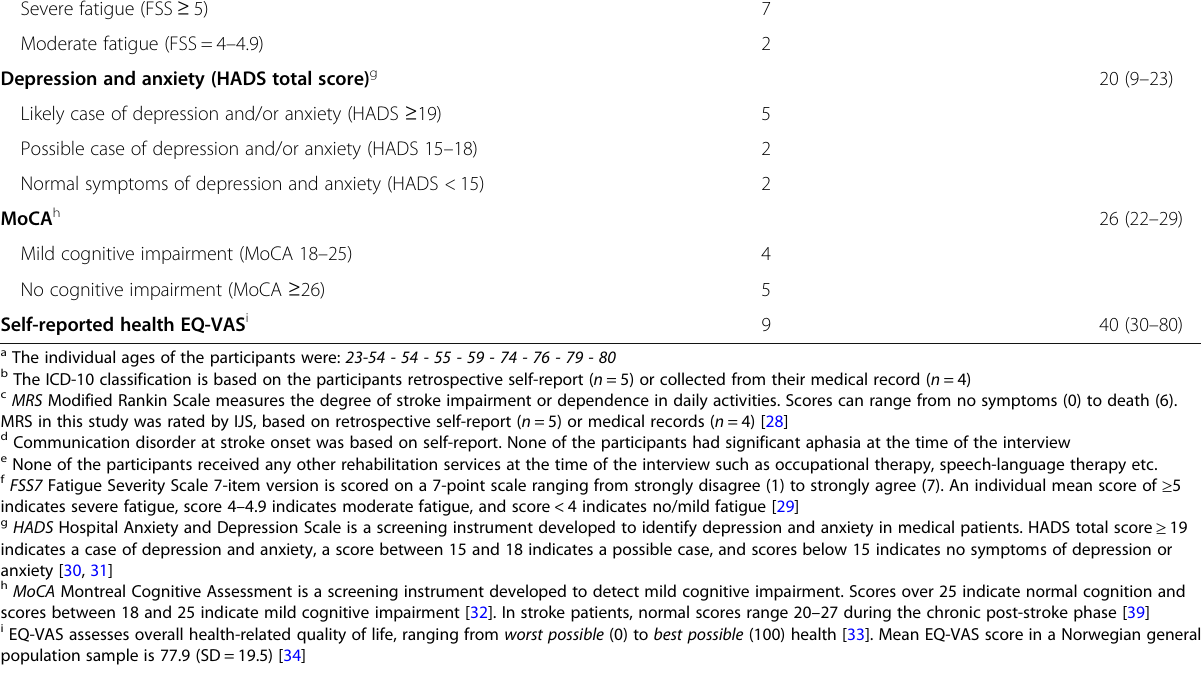
Moderate fatigue (FSS = 4 – 4.9)